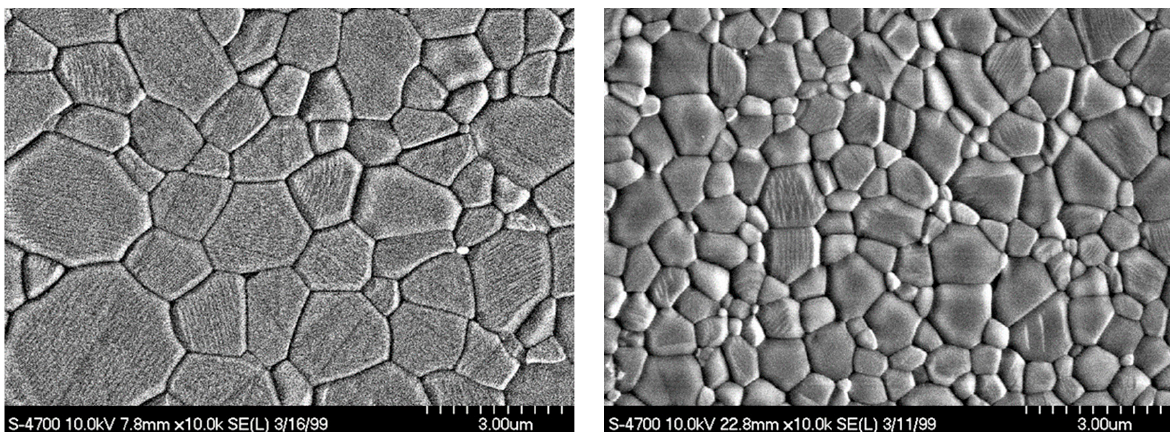
Figure 3. Microstructure of alumina ceramics; left : starting powder with a mean grain-size of 0.33 µm; right : starting powder with a mean grain-size of 0.22 µm.